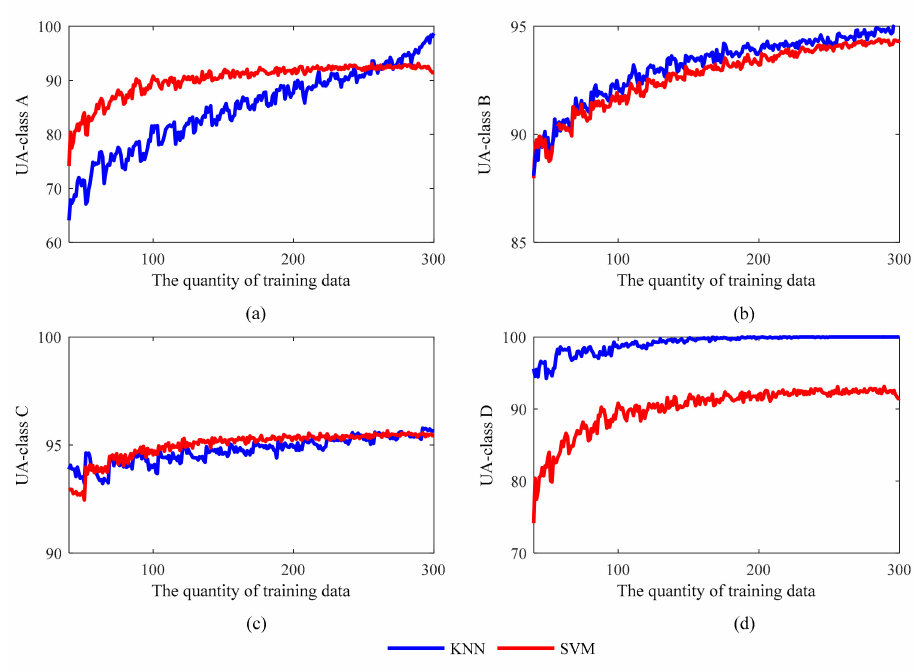
Figure 15. The User’s accuracy (UA) of KNN and SVM of four generalized weather classes. ( a ) UA values of GWC A; ( b ) UA values of GWC B; ( c ) UA values of GWC C; ( d ) UA values of GWC